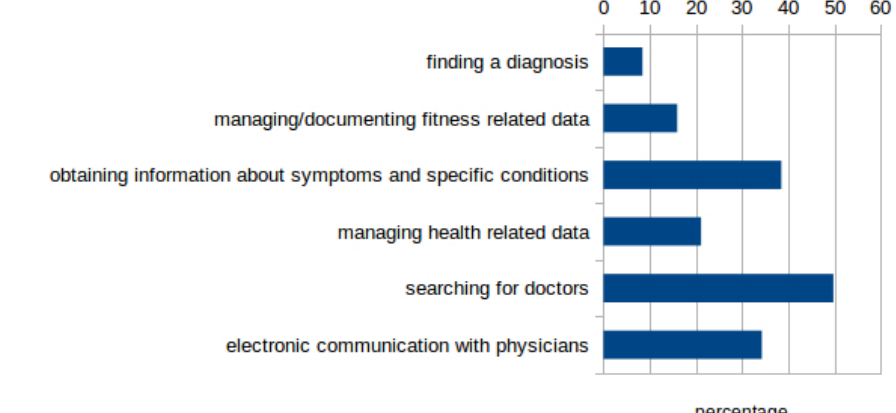
Figure 3. Health related activities patients would like to perform with their mobile